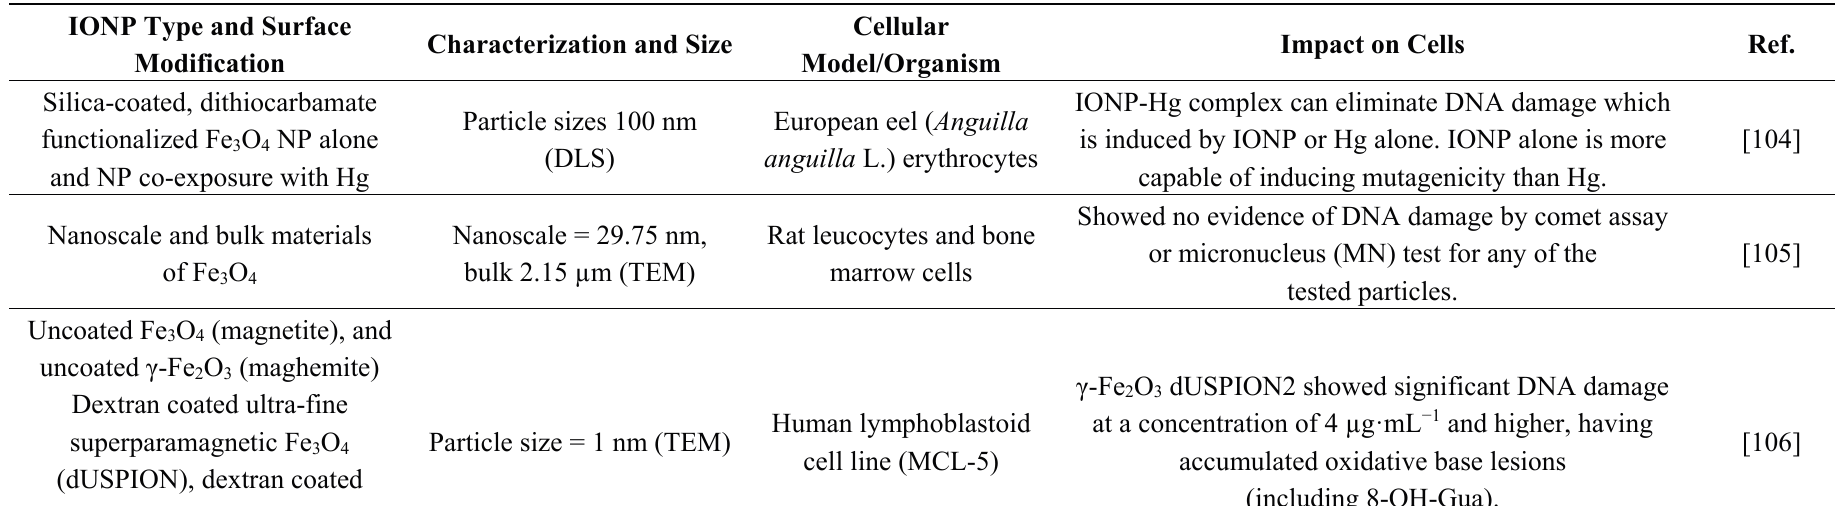
Table 1. IONP and DNA damage evidences from past